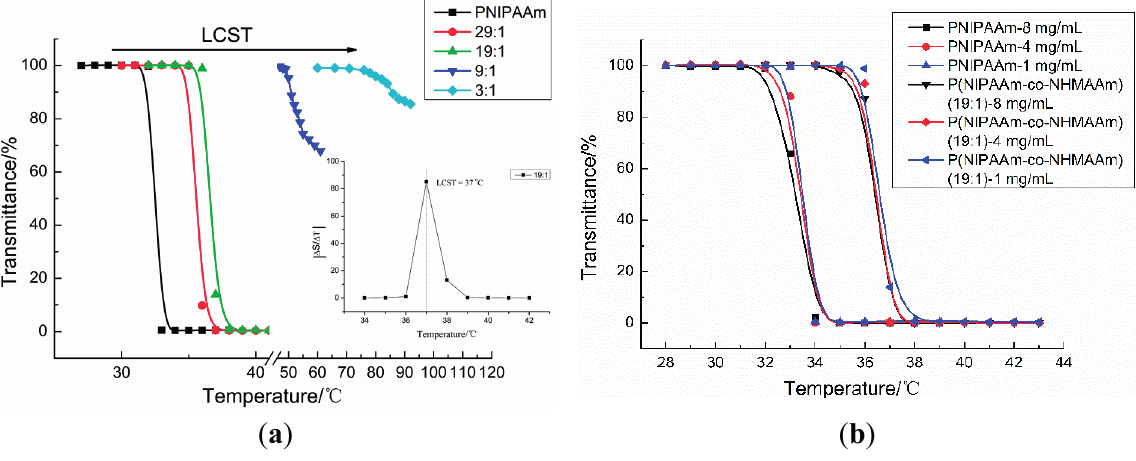
Figure 2. Temperature dependence for optical transmittance (500 nm) of copolymer solutions: ( a ) concentration: 1 mg/mL; ( b ) concentration: 1, 4, 8 mg/mL.